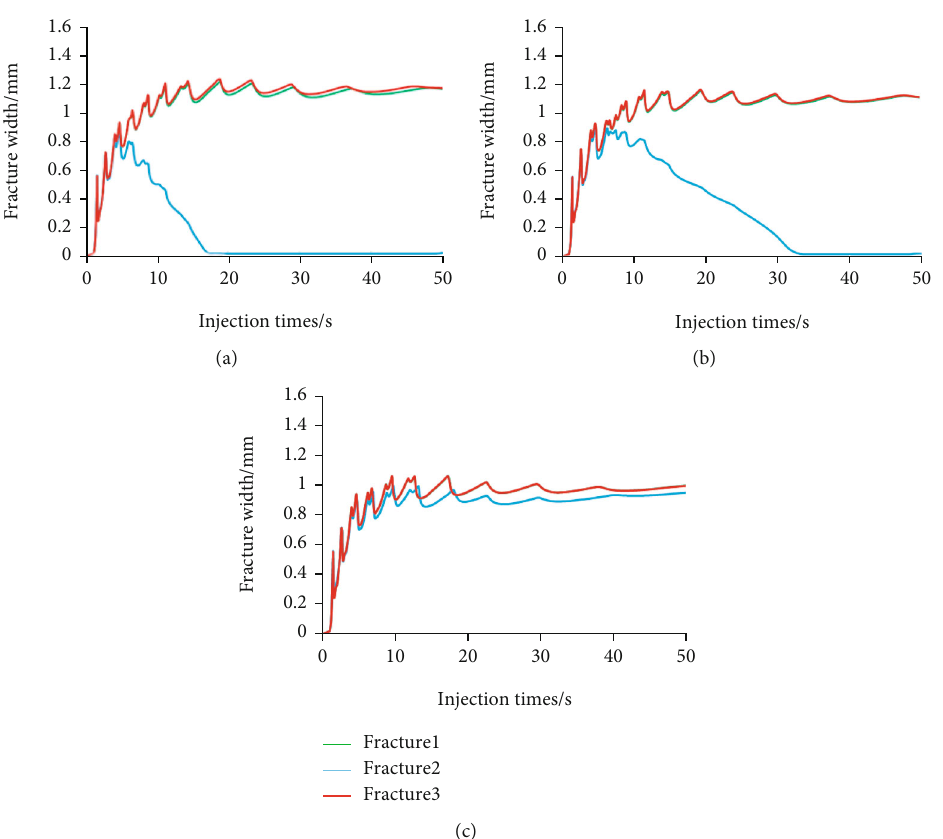
Figure 15: The maximum fracture width of each cluster as a function of time for di ff erent perforation design parameters: (a) case 1; (b) case 4; (c) case